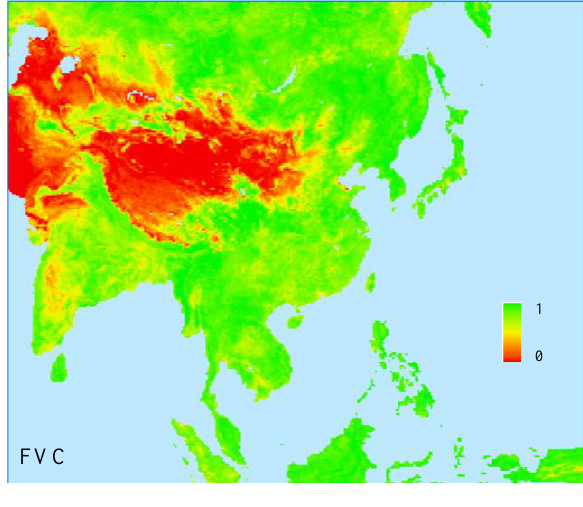
Figure 5. The geographic distributions of FVC derived from the April 1992–March 1993 AVHRR over the Asia RCM domain.